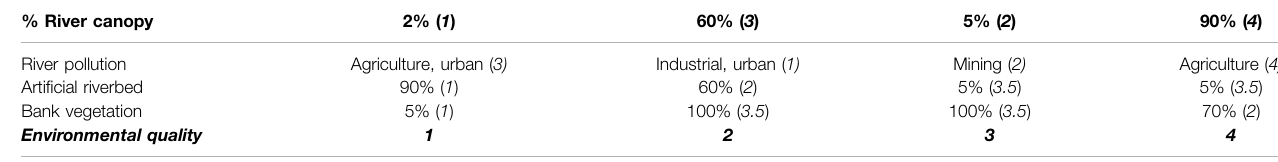
TABLE 3 | River features. Environmental quality, including canopy, pollution, arti fi cial riverbed, bank vegetation coverage. Rank scores of river features. % River canopy